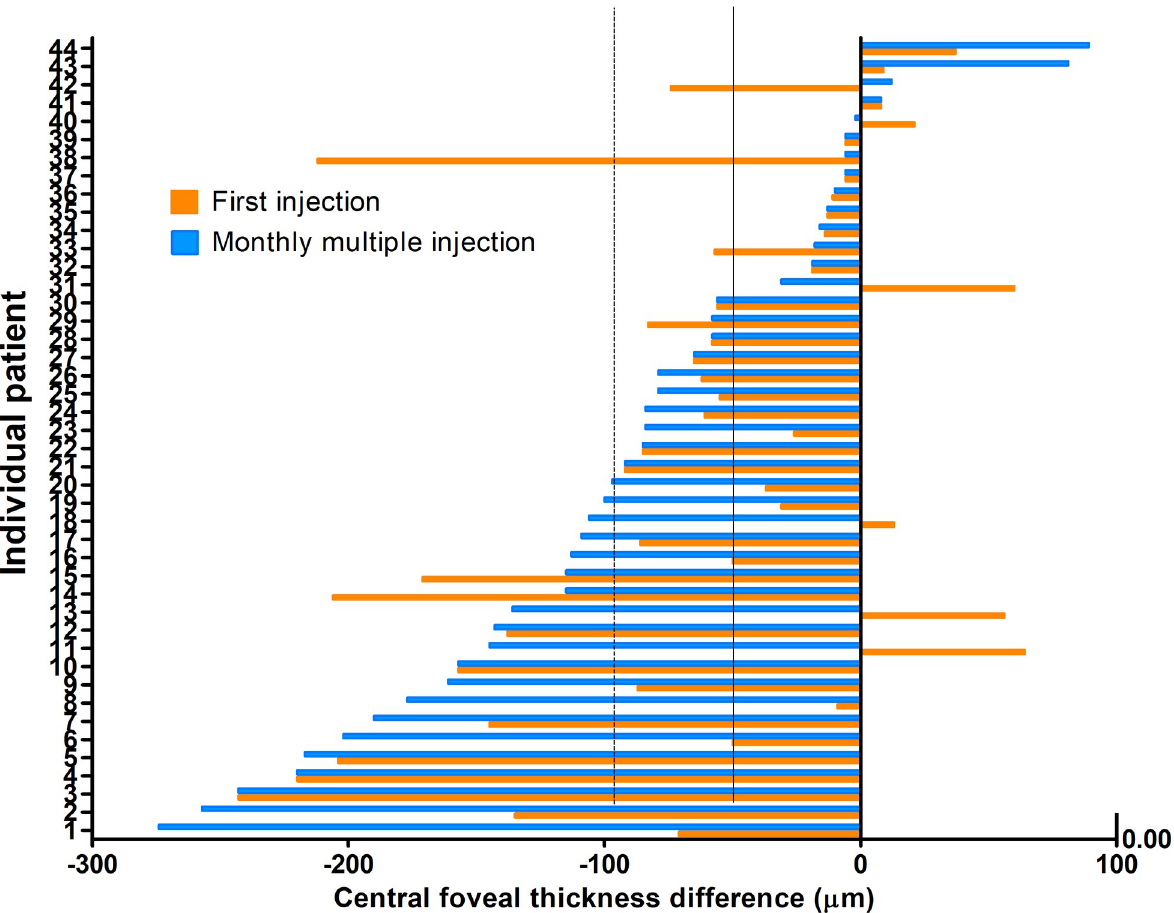
Fig 4. Central foveal thickness (CFT) difference of each eye. Solid and dotted line represents median CFT at 1 month after first injection and monthly multiple injections, respectively.